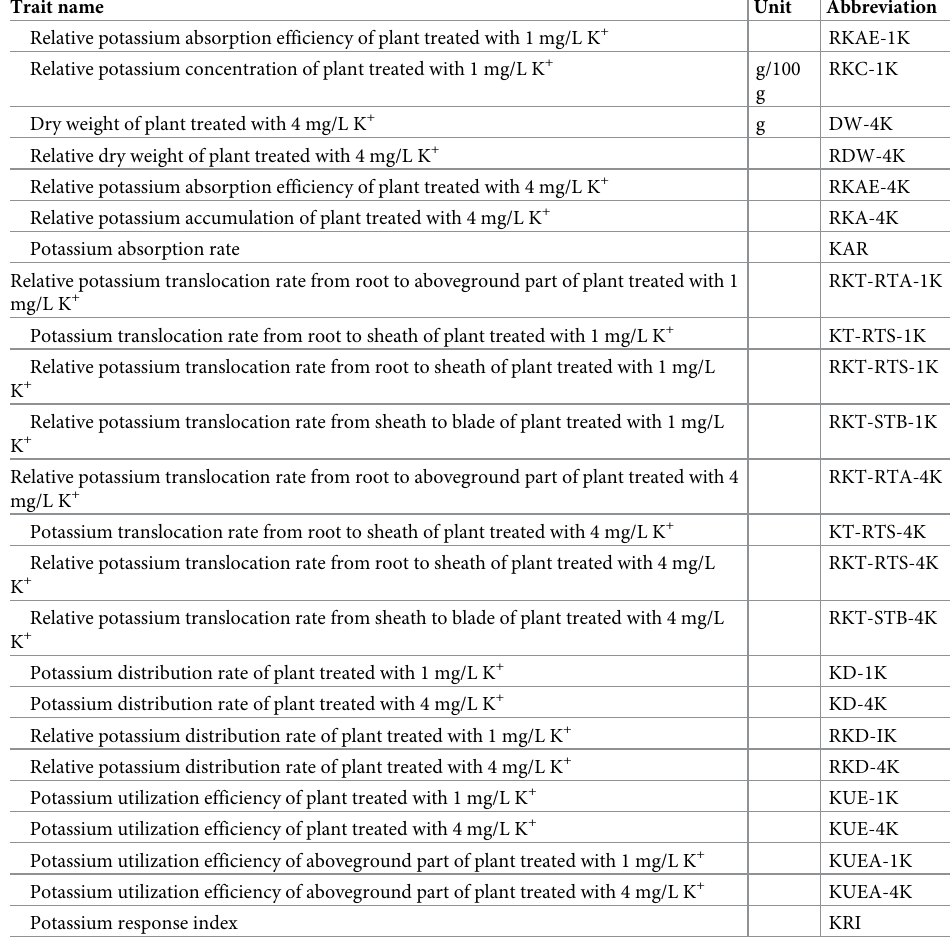
Table 2. Abbreviations of all investigation